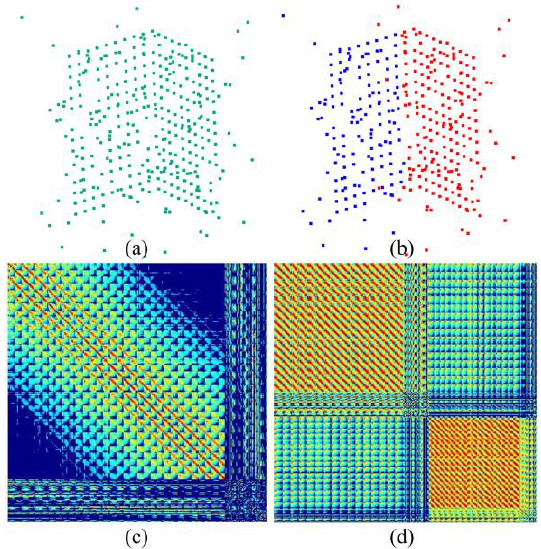
Figure 3. A simple example of subspace clustering. a) The point cluster contaminated with noises and outliers. b) The subspace clustering results. c) The original similarity matrix. d) The reordered similarity matrix after subspace clustering.